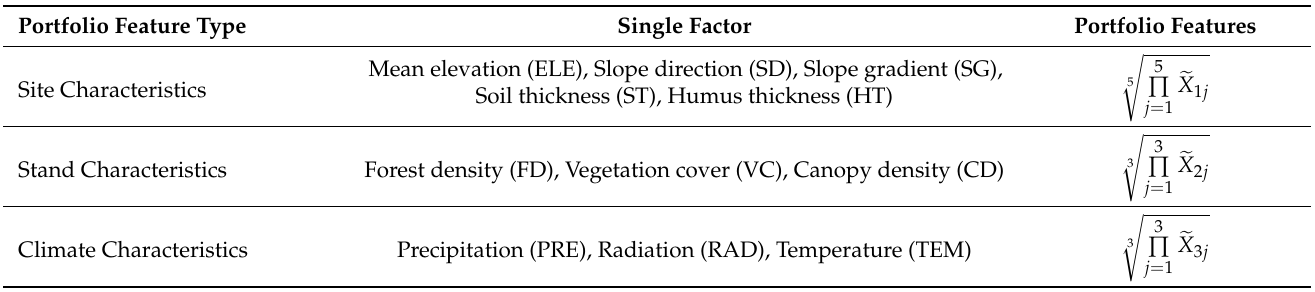
Table 2. Selection of single-factor and combined characteristics of the conditional